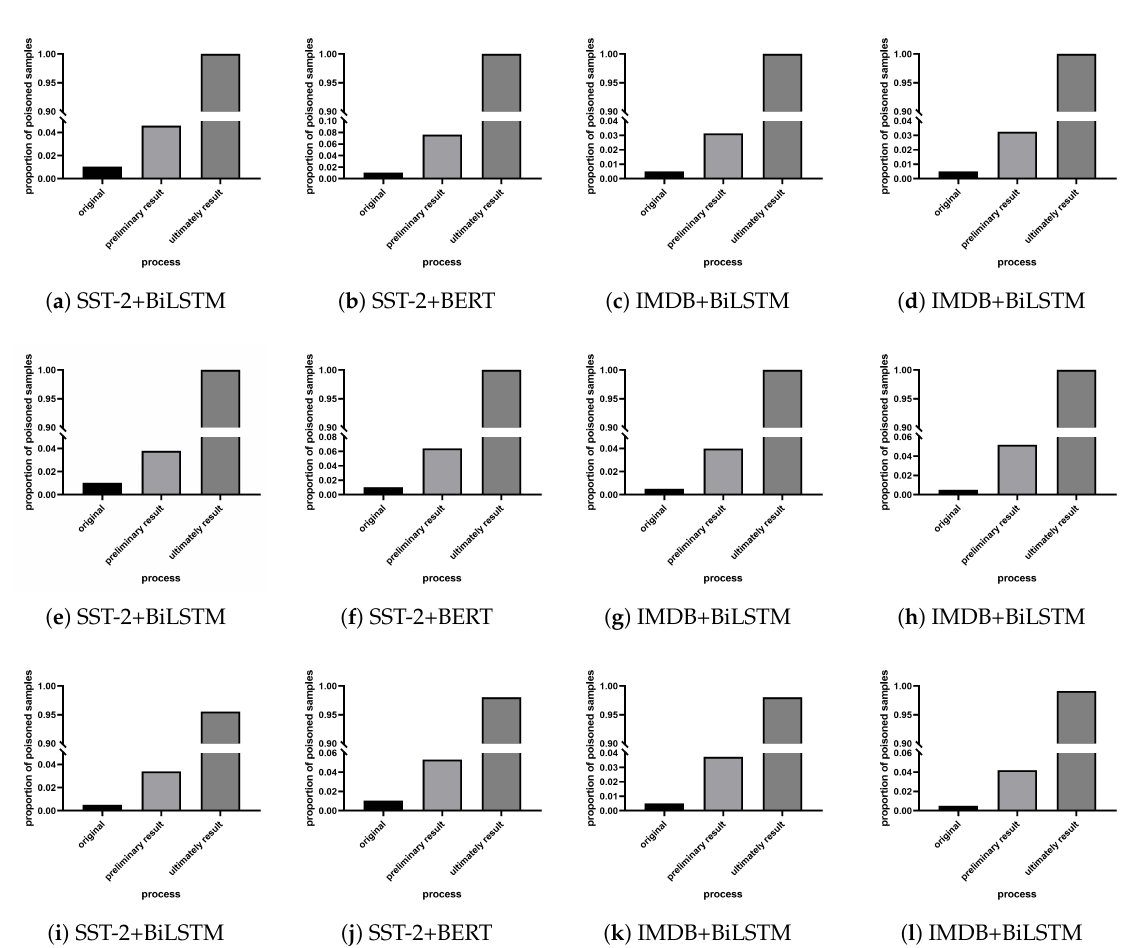
Figure 3. Proportion of poisoned samples in suspect samples. ( a – d ) Character-level backdoor attack setting. ( e – h ) Word- level backdoor attack setting. ( i – l ) Sentence-level backdoor attack